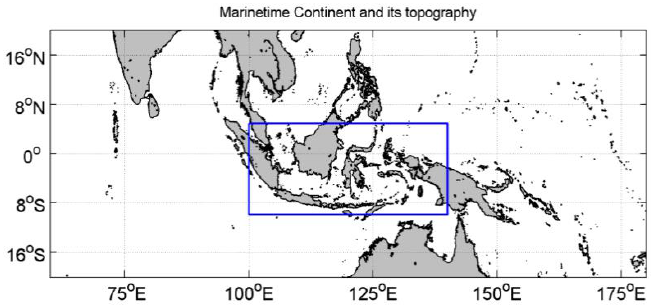
Figure 1. The terrain of the Maritime Continent (blue rectangle) and adjacent areas.